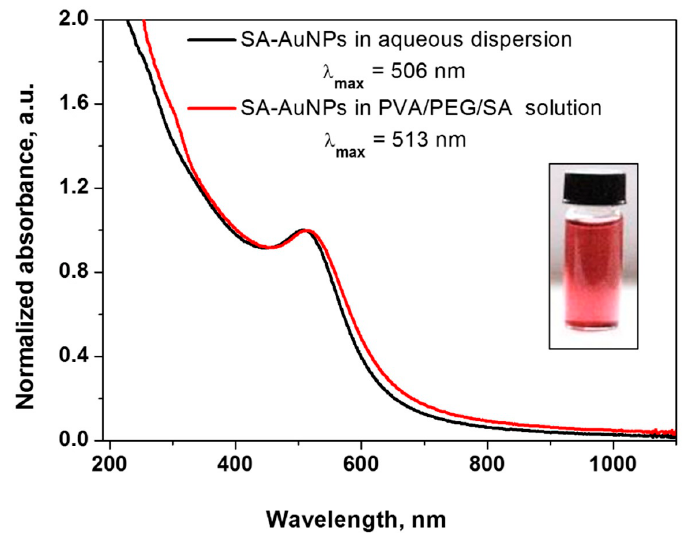
Figure 2. UV-vis absorption spectra of SA-AuNPs in: aqueous dispersion (red line) and PVA/PEG/SA hydrogel matrix solution (black line); inset: optical photo of SA-AuNPs aqueous dispersion.